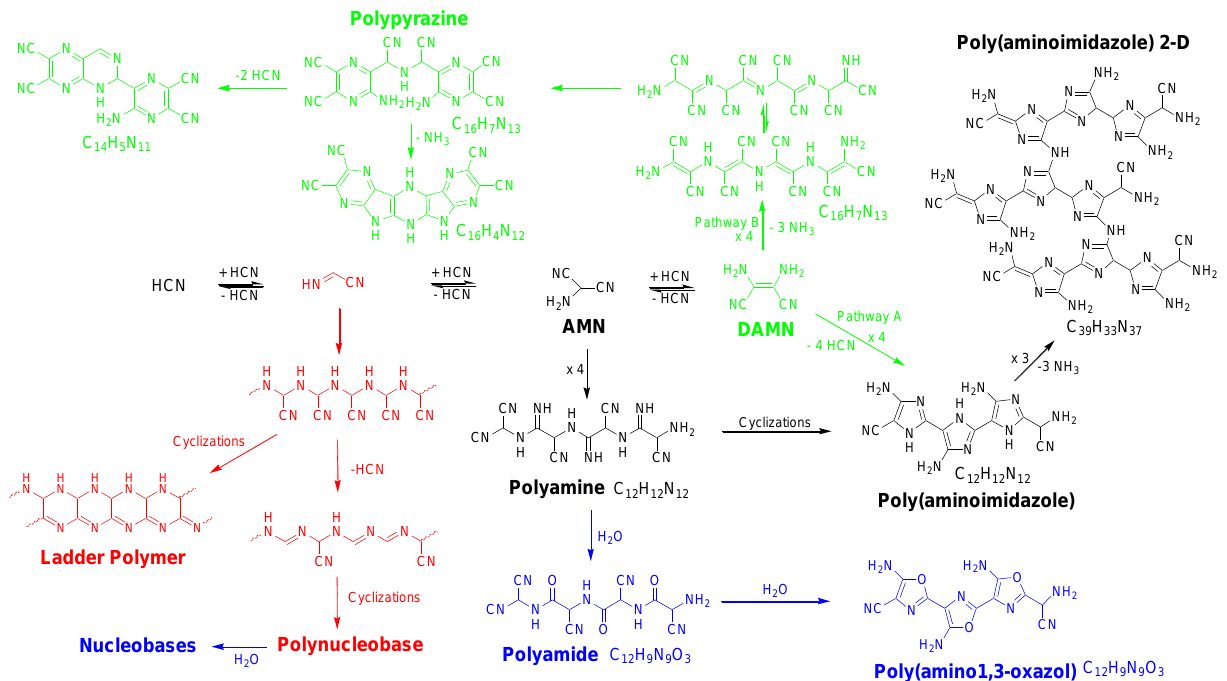
Scheme 2. General pathways for the generation of HCN-derived polymers in water. In this scheme is shown the oligomer formation as far as the tetramer DAMN, as well as proposed macromolecular structures from the dimer (red color), the trimer (AMN) (black color) and DAMN (green color) according to recent works [1,3,4,23]. Note that the incorporation of oxygen in some of the structures for the suggested macromolecular systems was due to hydrolytic processes (blue color).